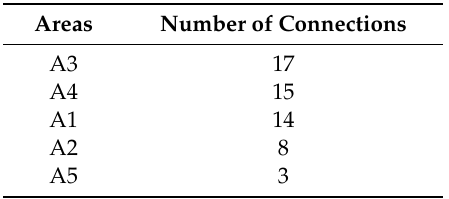
Table 9. The number of connections related to the